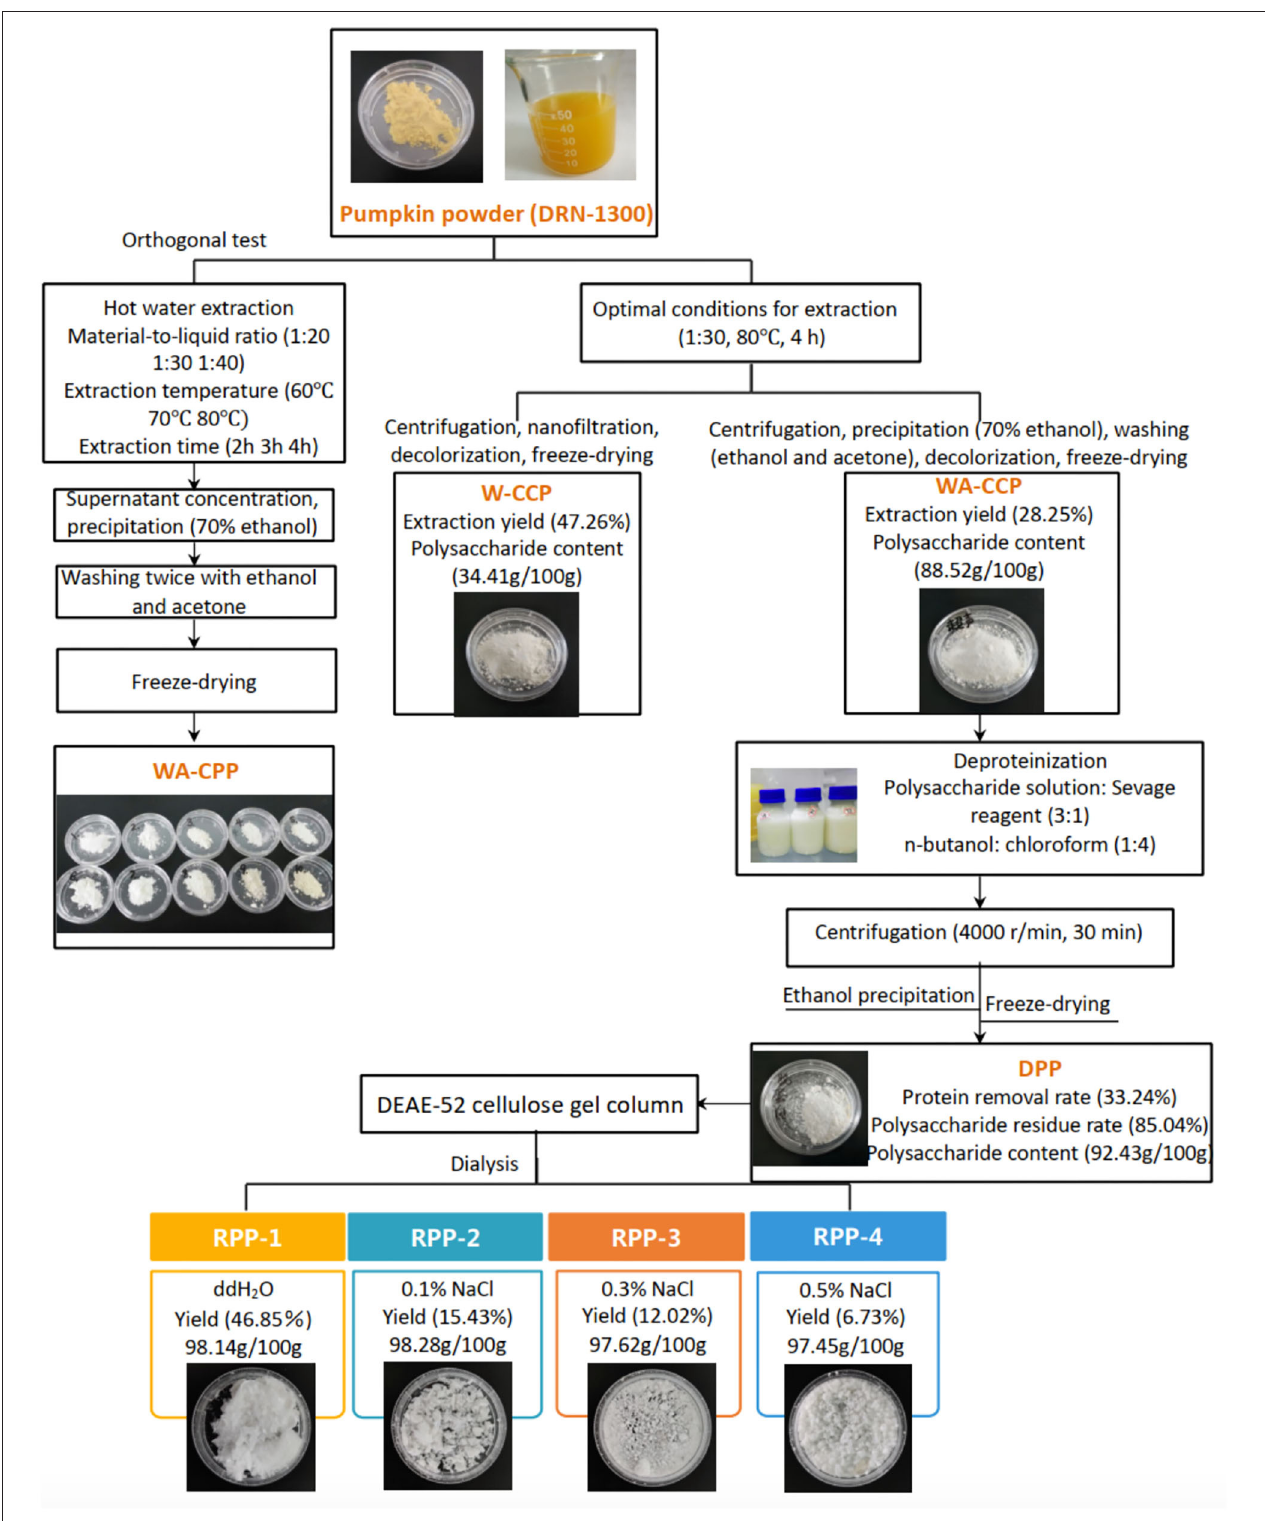
FIGURE 1 | Pumpkin polysaccharide sequential extraction and purification process flow. W-CPP, water-extracted crude pumpkin polysaccharides; WA-CPPs, crude pumpkin polysaccharides extracted by water and alcohol; DPPs, deproteinized pumpkin polysaccharides; RPPs, refined pumpkin polysaccharides.